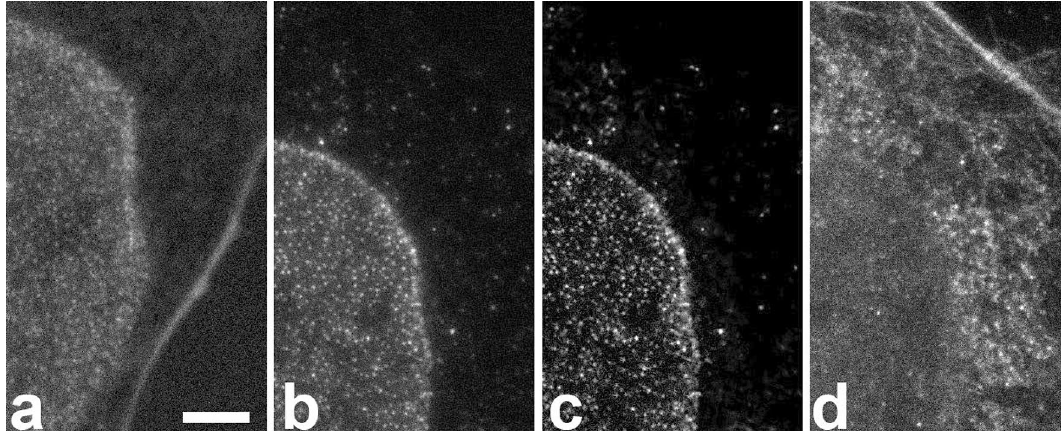
Figure 2. Crosstalk of far red dyes into the CF680R nuclear pore channel is observed with 670 nm excitation but not with 685 nm. Scale bar 2 µm for all images. ( a ) Excitation of a five color sample with 670 nm. The detection window was 701–750 nm. This raw image prior to Tau-STED processing shows substantial crosstalk from ATTO 647N (actin staining, strong fiber in the image from bottom to right) while Abberior STAR 635P (mitochondria) crosstalk is hardly above background. ( b ) Excitation of a different cell with 685 nm on another microscope shows no sign of crosstalk from other dyes. A haze around the nuclear pores is due to anti-stokes excitation of CF680R by the depletion beam. ( c ) The same image after Tau-STED processing which removed the anti-Stokes contribution. ( d ) Raw image of the area shown in ( b , c ) in the far red channel with actin and mitochondrial staining, demonstrating the presence of both structures and their